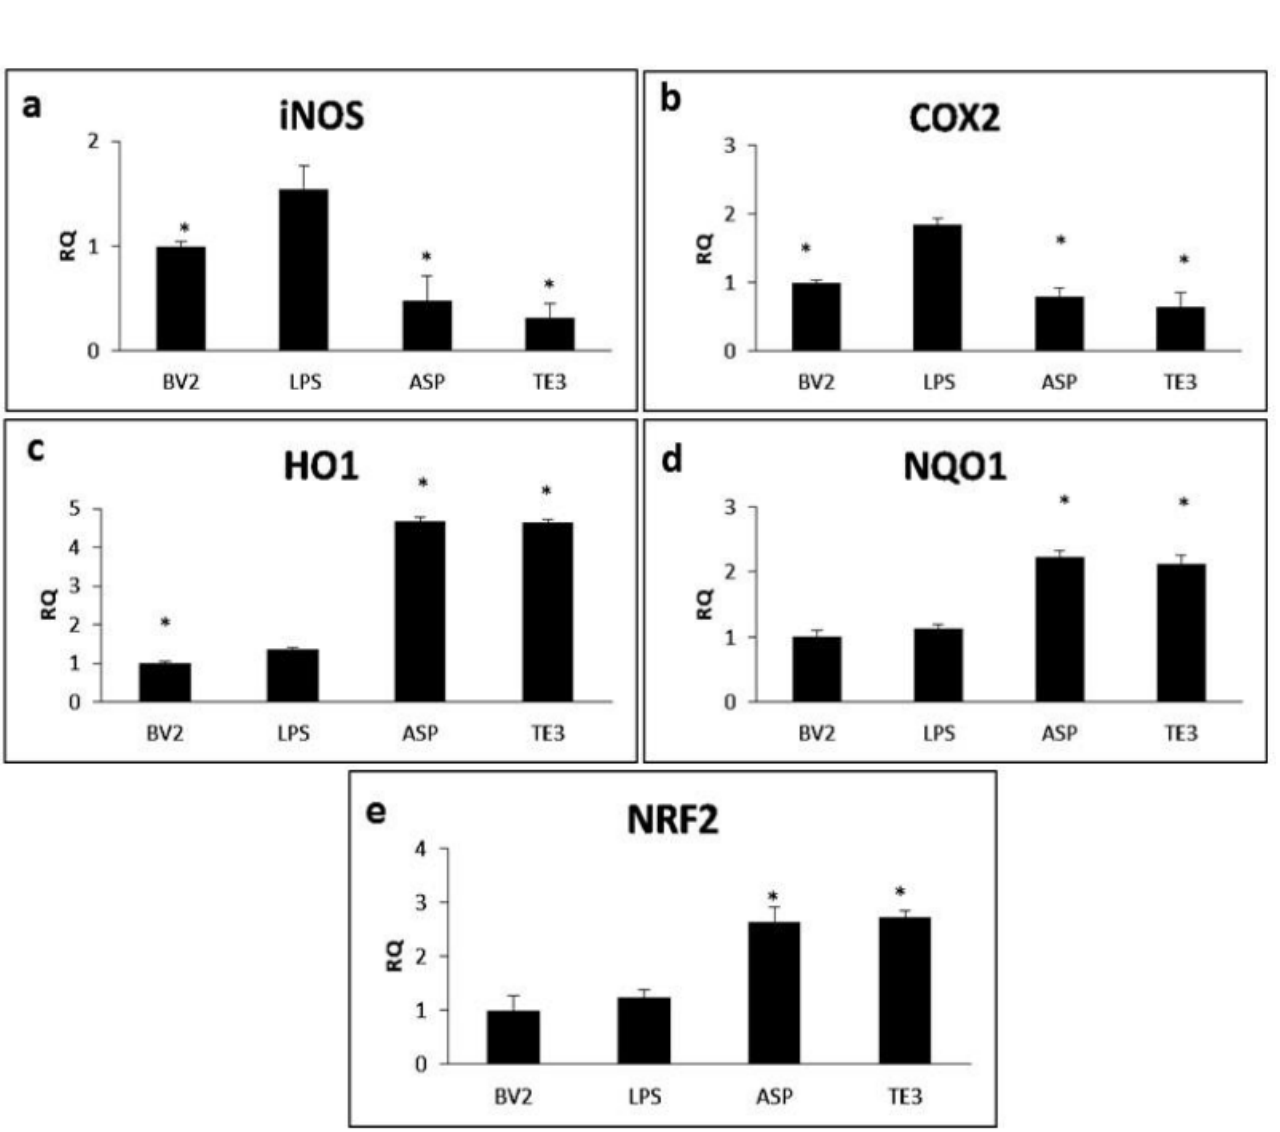
FIGURE 2A - The effect of different treatments in LPS stimulated BV2 cells on inflammatory genes; i.e. (a) iNOS, (b) COX2, (c) HO1, (d) NQO1, and (e) Nrf2. Fold increase values are calculated relative to the ACTB gene. BV2= untreated cells, LPS= LPS stimulated cells, ASP= Aspirin (100 uM), TE3= TE3 fraction (10 µg/mL) treatment in LPS stimulated BV2 cells. Data represent the mean ± SE and from a representative of three independent experiments carried out in triplicates. The * symbol denotes a significant difference (p<0.05) from the corresponding value of the negative control (LPS). RQ=relative